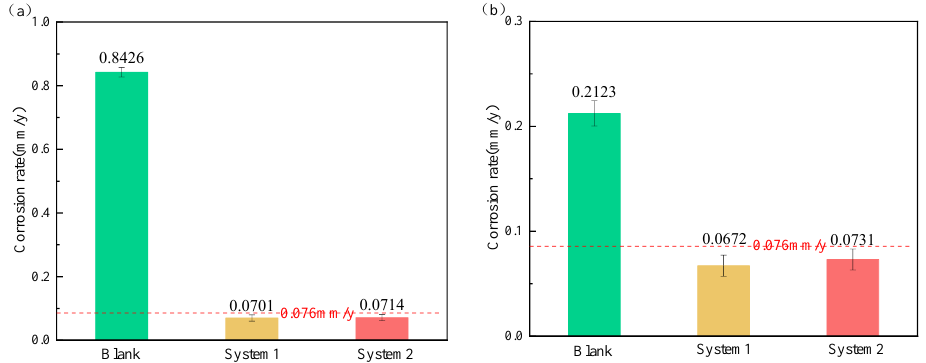
Figure 14. Corrosion rate of P110ss steel immersed in solution added with water-based annular protective liquid. ( a ) Liquid phase; ( b ) gas phase. protective liquid. ( a ) Liquid phase; ( b ) gas